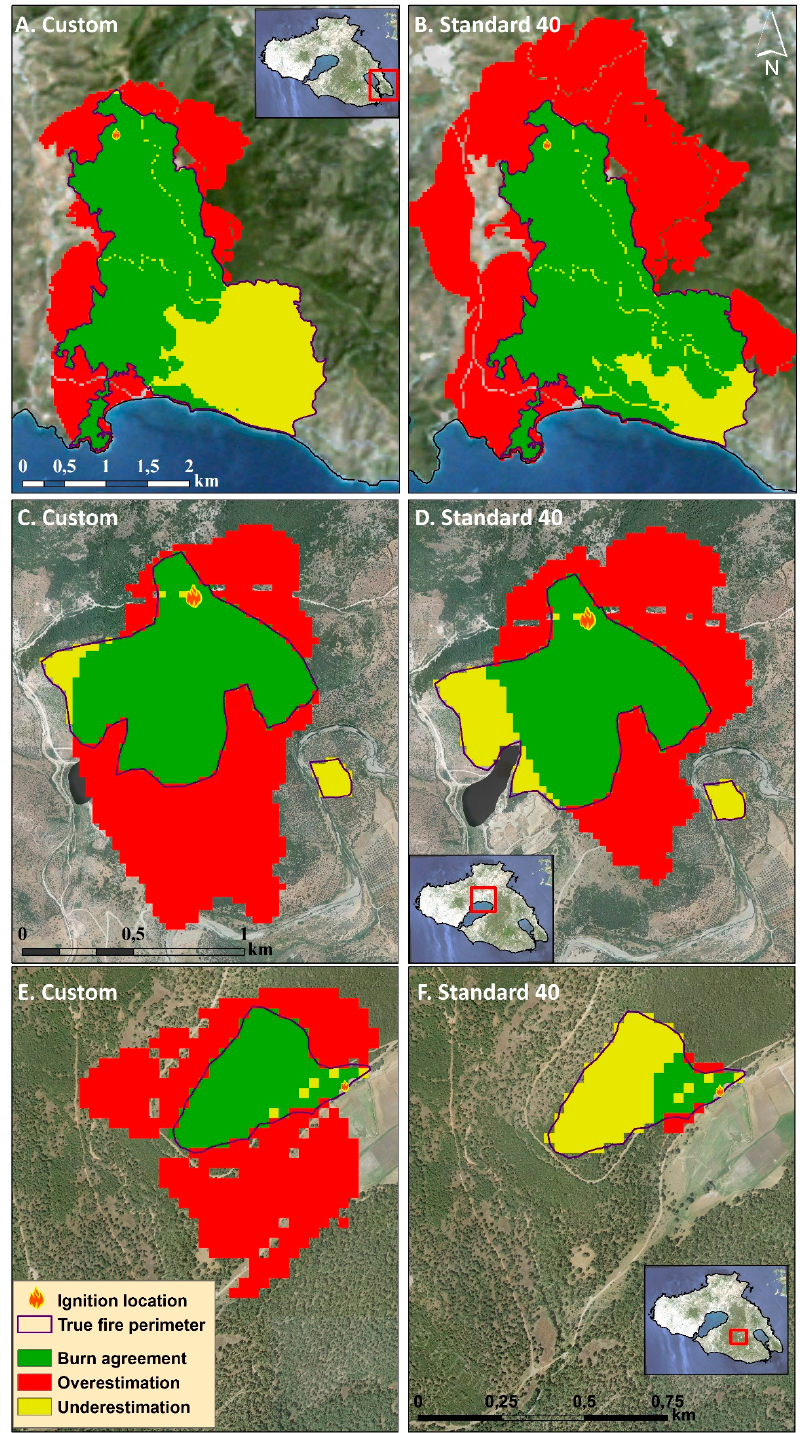
Figure A3. FARSITE simulation results comparing the four custom fuel models with the standard Scott and Burgan [51] fuel models for fires that burned mostly inside conifer fuel types. ( A , B ): southeast fire; ( C , D ): central-north fire; ( E , F ): central